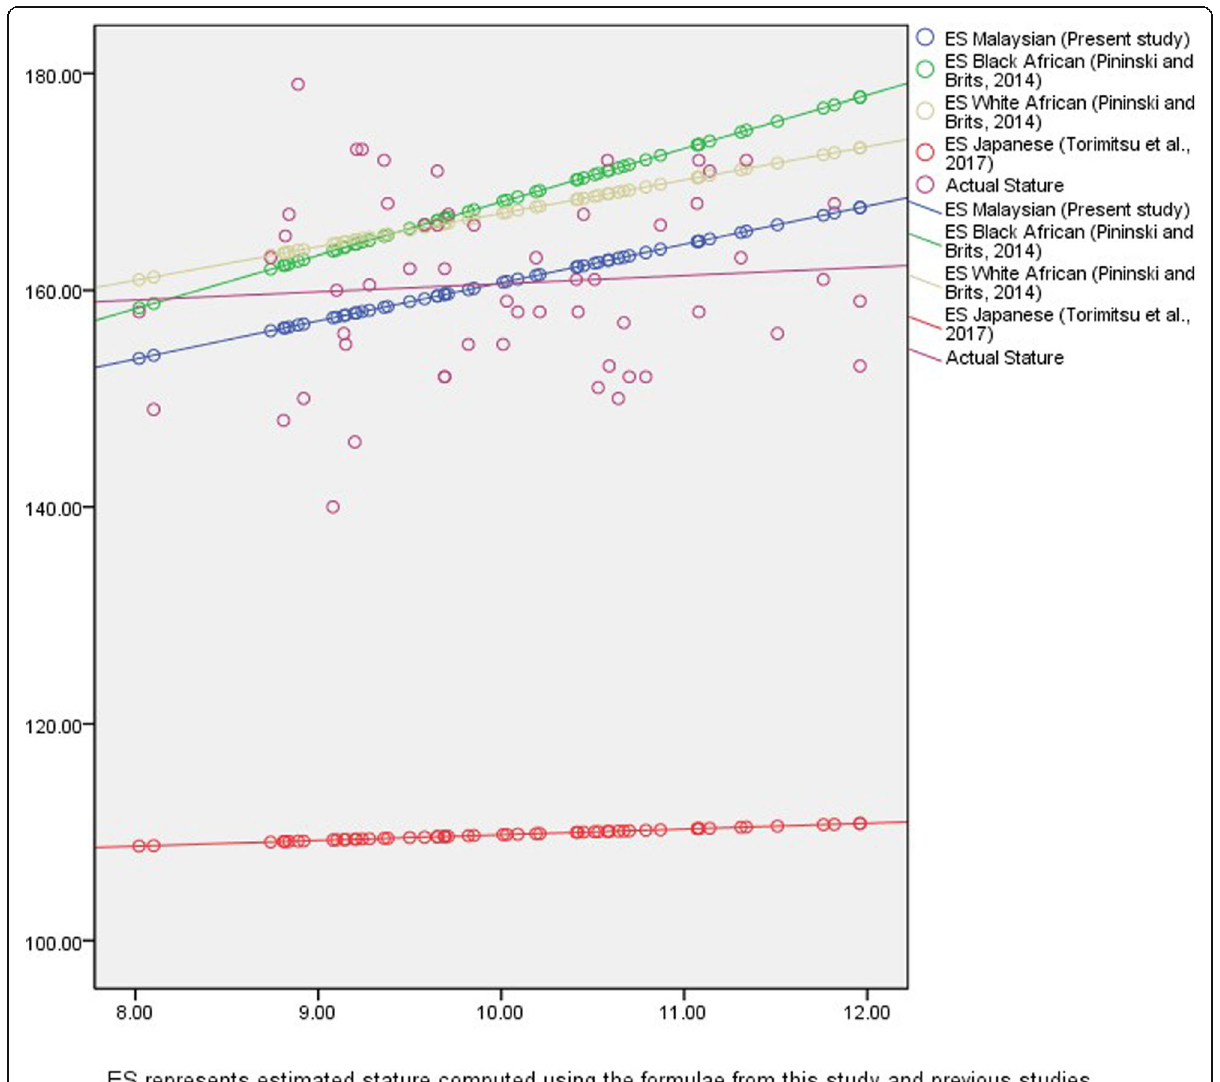
Fig. 3 Comparison of estimated stature by using formulae from different studies based on sacral height (P6) correlation with the actual stature